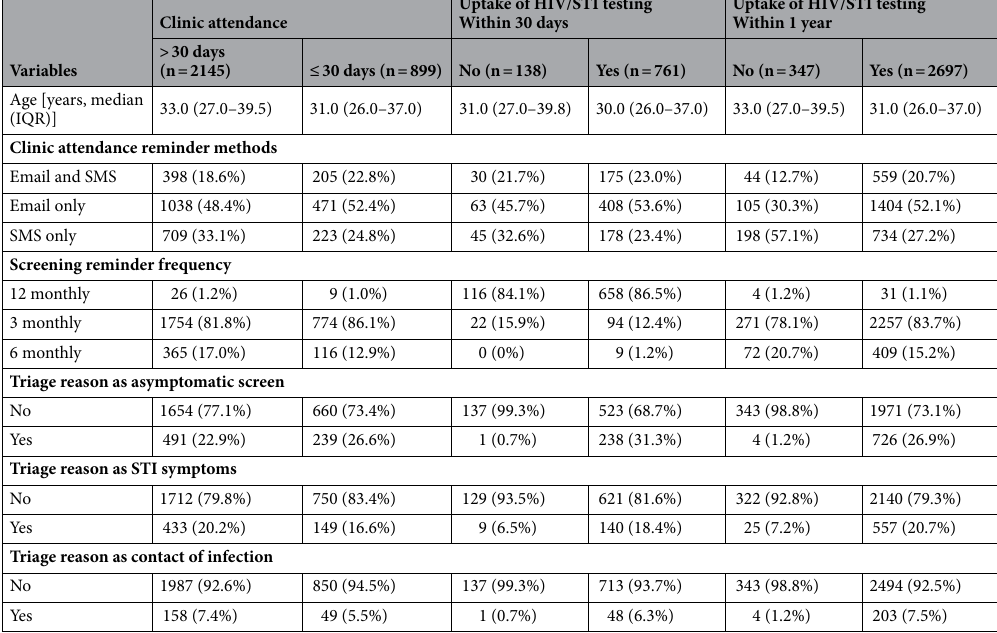
Table 1. Characteristics of MSM stratified by their timing of clinic attendance after receiving a reminder message and HIV/STI testing post clinic reminder message. IQR interquartile